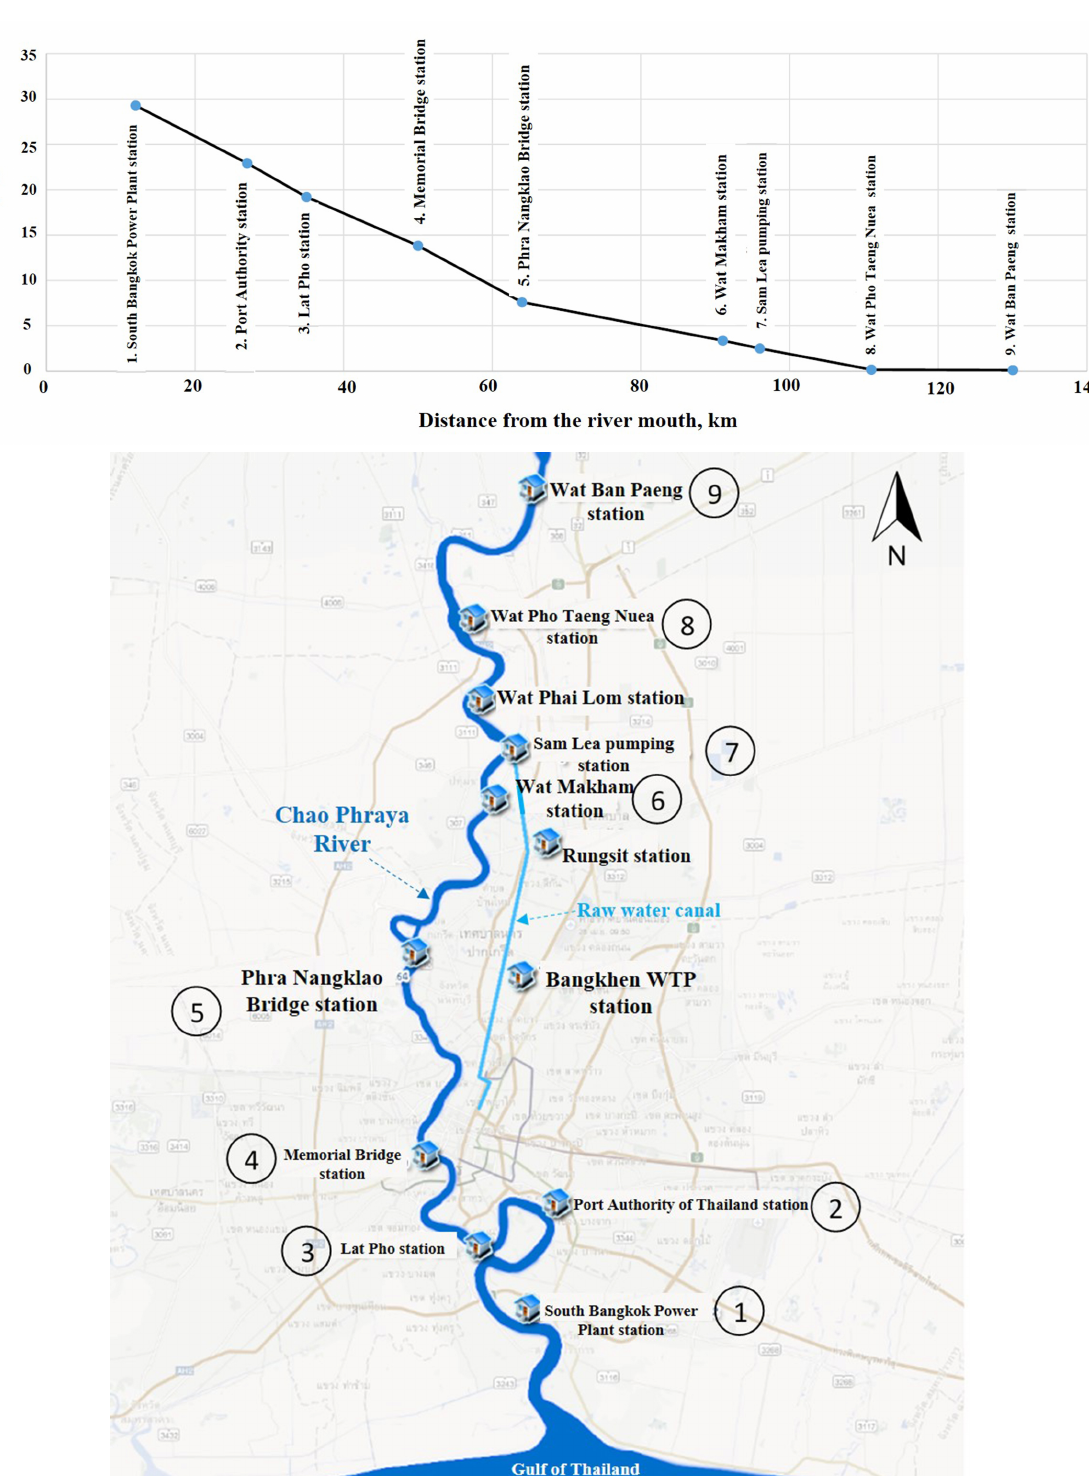
Fig. 4. Monitored salinity at different locations along the Chao Phraya River on 30 January 2021. have been transformed from an almost undisturbed to a surface water and groundwater systems has been observed human-impacted state as well as saltwater intrusion into to be negatively affecting groundwater reserves [17].